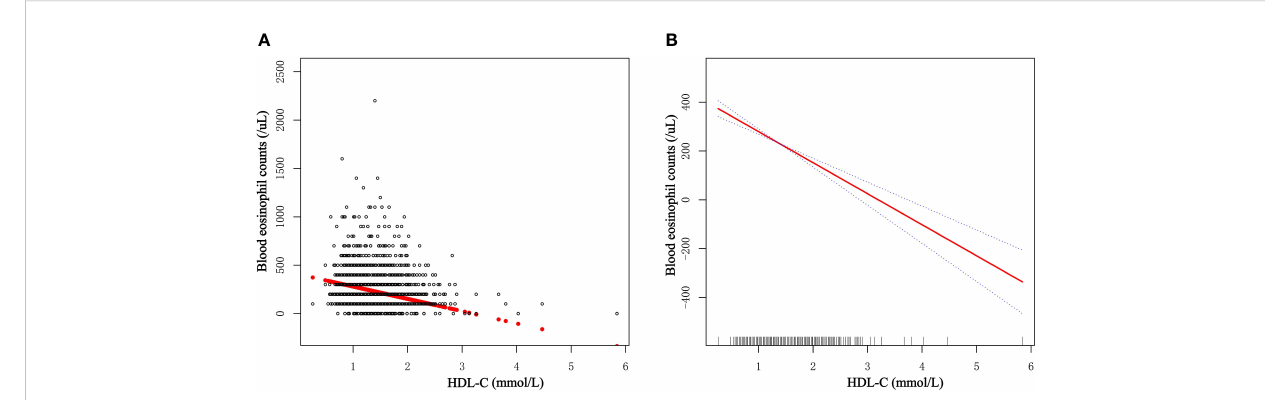
FIGURE 3 Dose-response relationship of serum HDL-C levels with blood eosinophil counts among asthmatic adults. (A) Each dot represents an individual sample. (B) The solid red line indicates the smooth fi tting curve between serum HDL-C and blood eosinophil counts, whereas the dotted blue line represents 95% con fi dence intervals of the fi